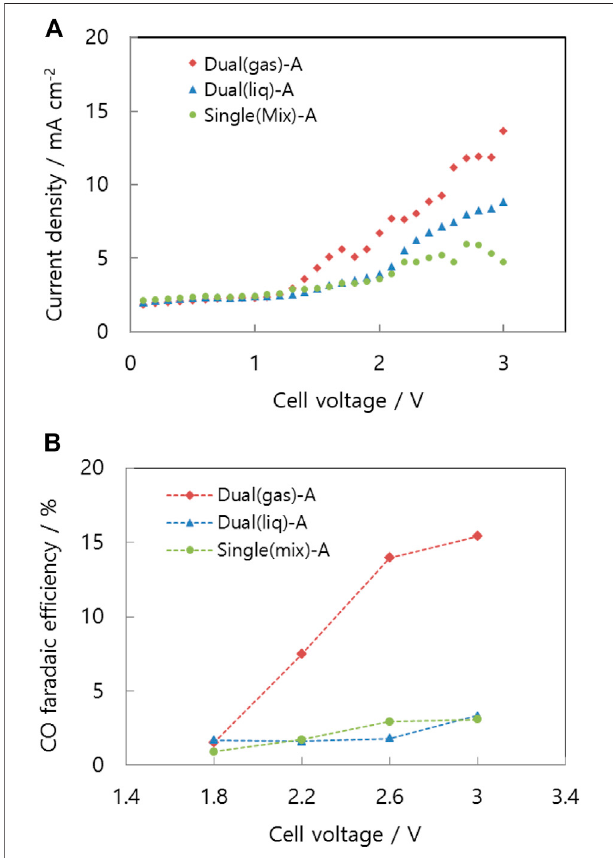
FIGURE 6 | (A) Voltage-current curve and (B) CO faradaic ef fi ciency of the differently structured cells: Dual (gas)-A, Dual (liq)-A, and Single (mix)-A.